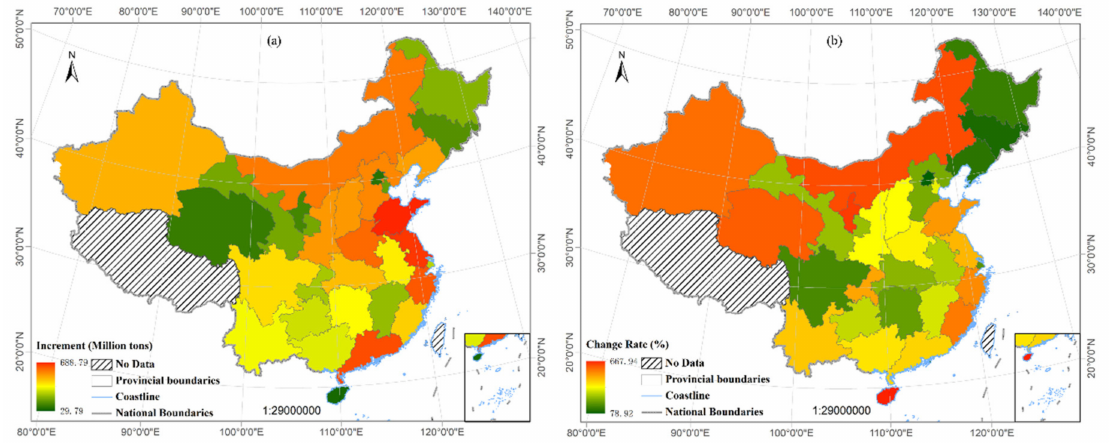
Figure 3. CEs increase ( a ) and AAGR ( b ) of 30 Provinces,